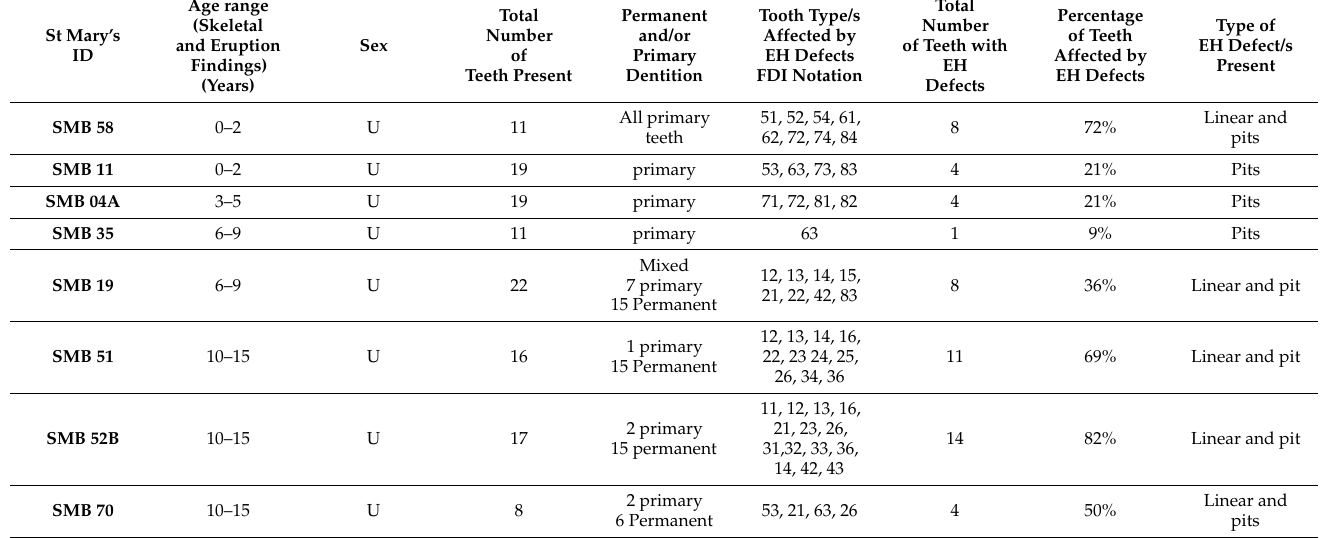
Table 5. Number and percentage of enamel hypoplastic (EH) defects identified in the individuals from the St Mary’s sample with antemortem tooth